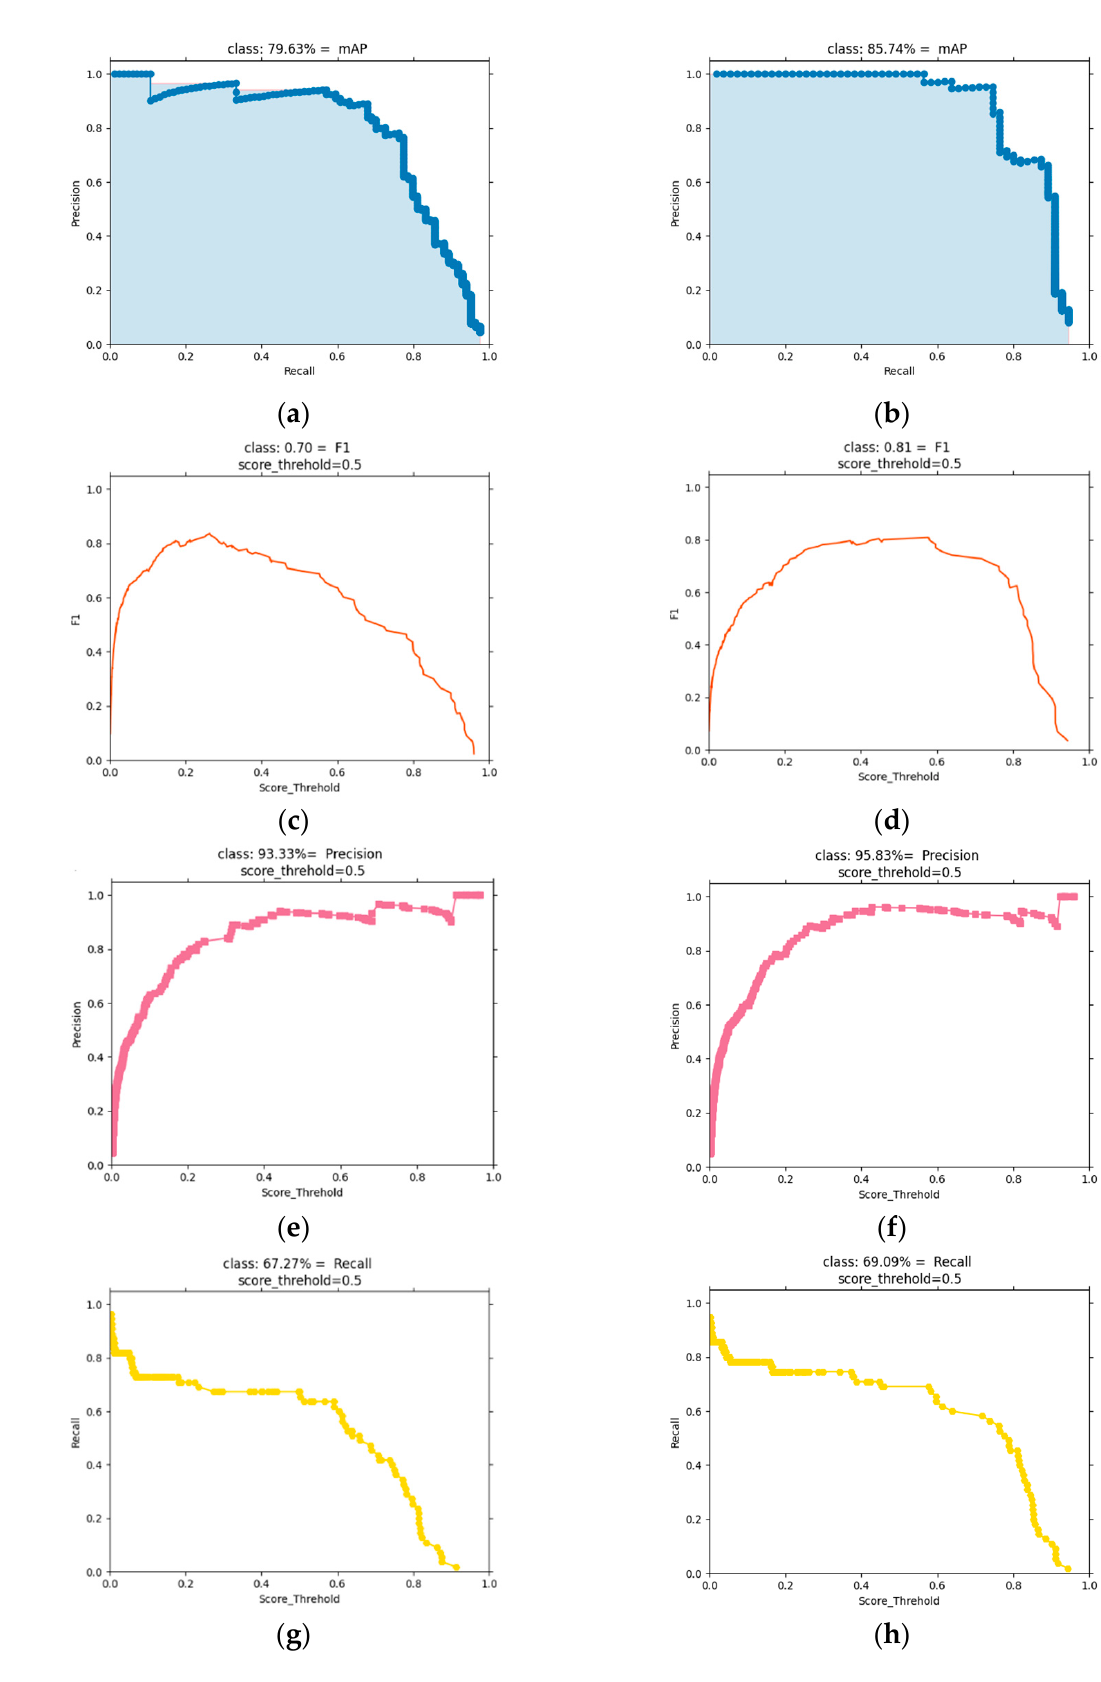
Figure 5. Comparison of network model training results. ( a – h ), respectively, represent PR curve, F1 score curve, precision curve and recall curve.